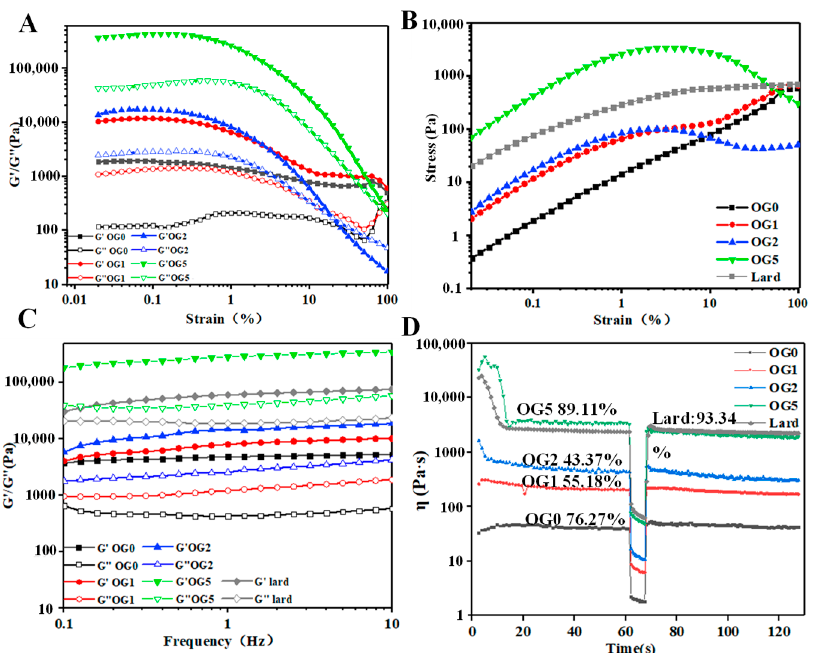
Figure 3. Rheological behavior of the oleogels. ( A ): Strain sweep. ( B ): Stress–strain curves obtained from strain sweeps. ( C ): Frequency sweep. ( D ): Thixotropy tests.